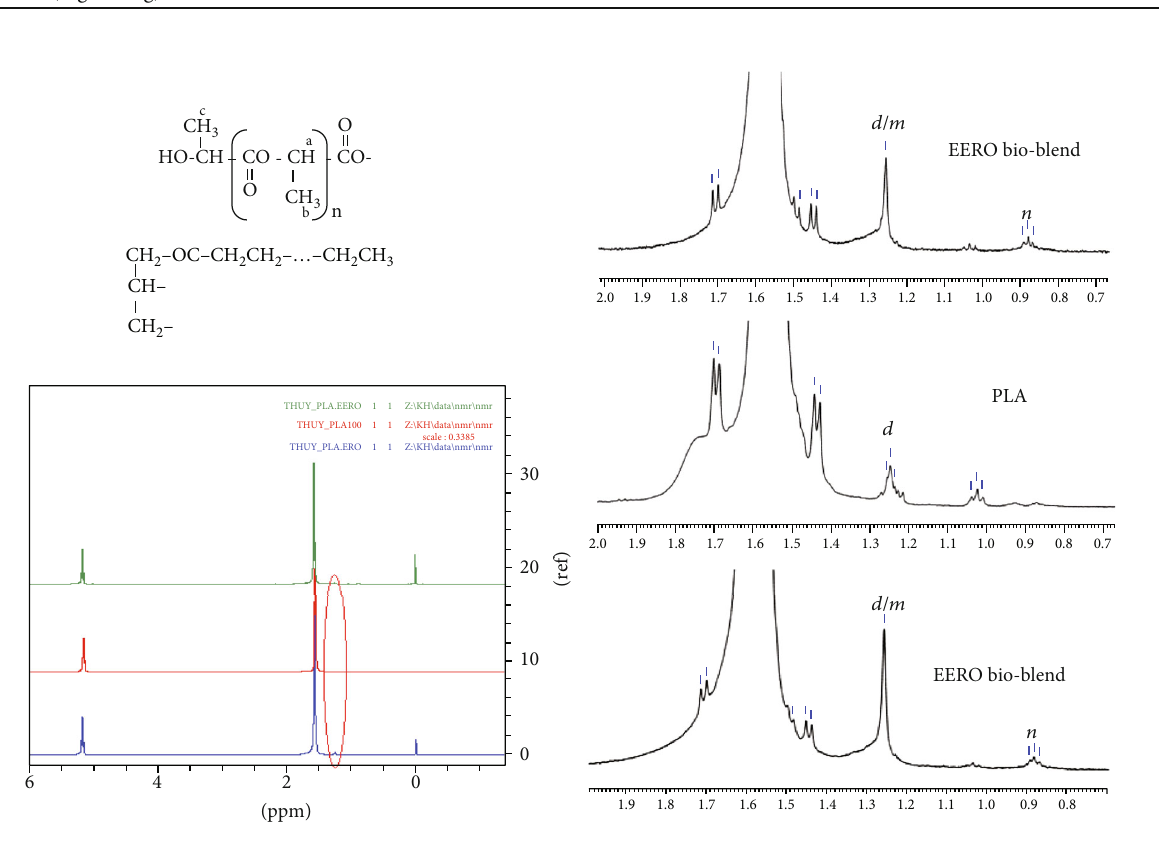
Figure 7: The H-NMR spectra of samples. Table 6: Assignment of the H-NMR spectra of samples.